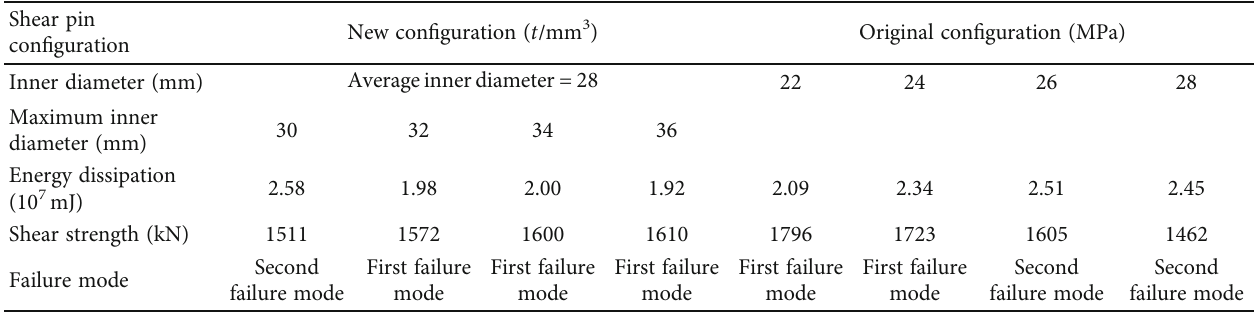
Table 3: Energy dissipation and shear strength of shear pins of di ff erent con fi